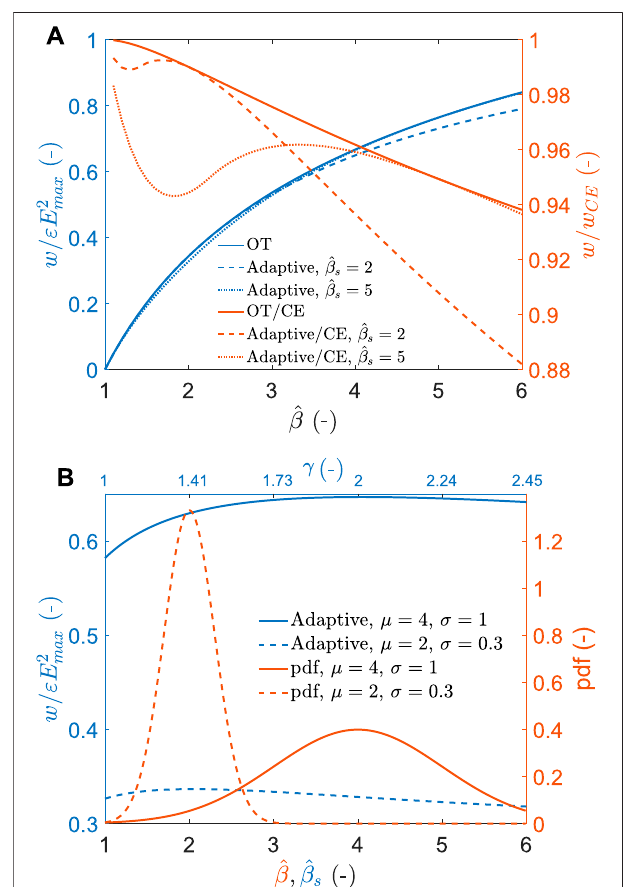
FIGURE 7 | (A) normalised energy density harvested as a function of capacitance swing ^ β using the adaptive strategy (blue). Two different arbitrary set points are shown: a circuit optimised for ^ β s (cid:1) 2 (dotted) and one for ^ β s (cid:1) 5 (dashed). The energy density of the OT cycle is shown (continuous) as a comparison. Red shows the relative energy produced compared to the CE cycle. (B) Red: two normal distributions of capacitance swing. Blue: average energyharvestedpercycleforthesamedistributionsofcapacitanceswing,as a function of the electronic circuit set point ^ β s